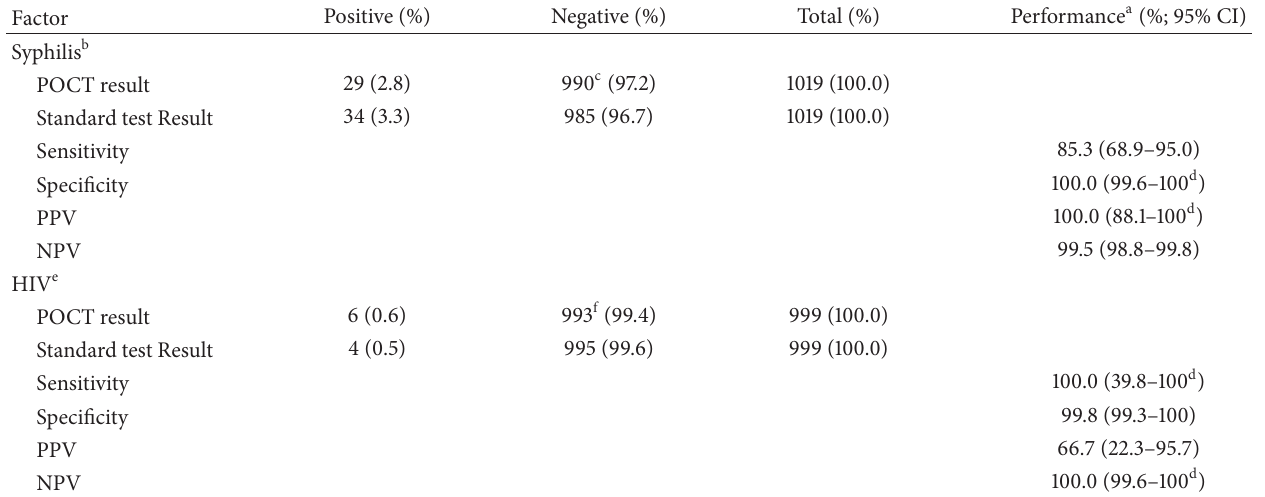
Table 3: Performance characteristics of syphilis and HIV point-of-care